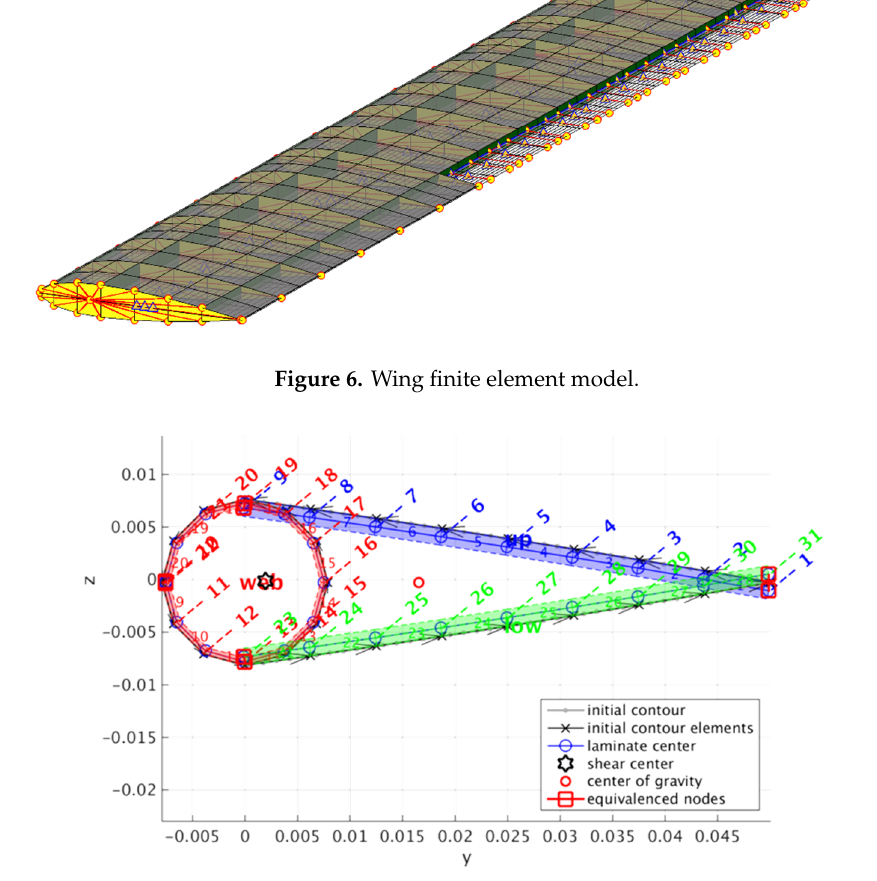
Figure 7. Flap cross-section.